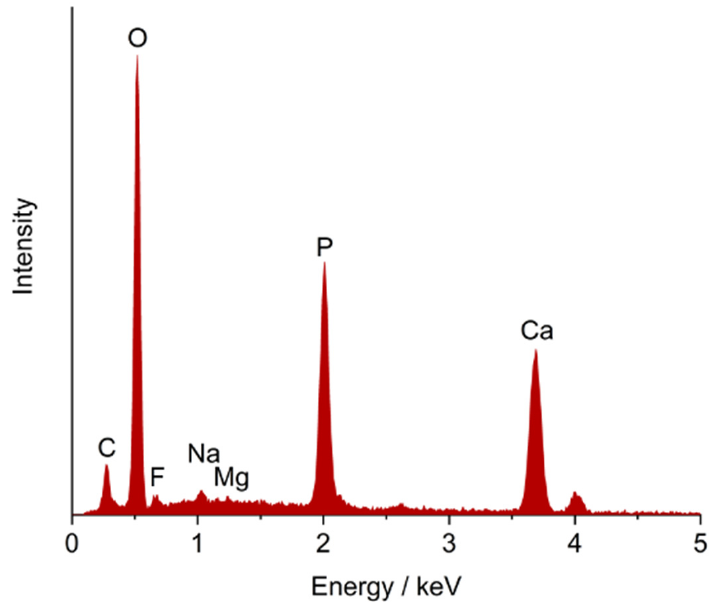
Figure 1. Representative EDX analysis of the enamel surface after treatment with a fluoride solution of 1 mol L − 1 (18,998 ppm fluoride). Hydroxyapatite in enamel gives rise to signals of oxygen (O), phosphorus (P), and calcium (Ca). Sodium (Na) and magnesium (Mg) are cationic substitutions in hydroxyapatite. Carbon (C) is due to carbonate substitution in hydroxyapatite and the organic part of enamel (matrix proteins). Fluorine (F) is present as an anionic substitution in hydroxyapatite.